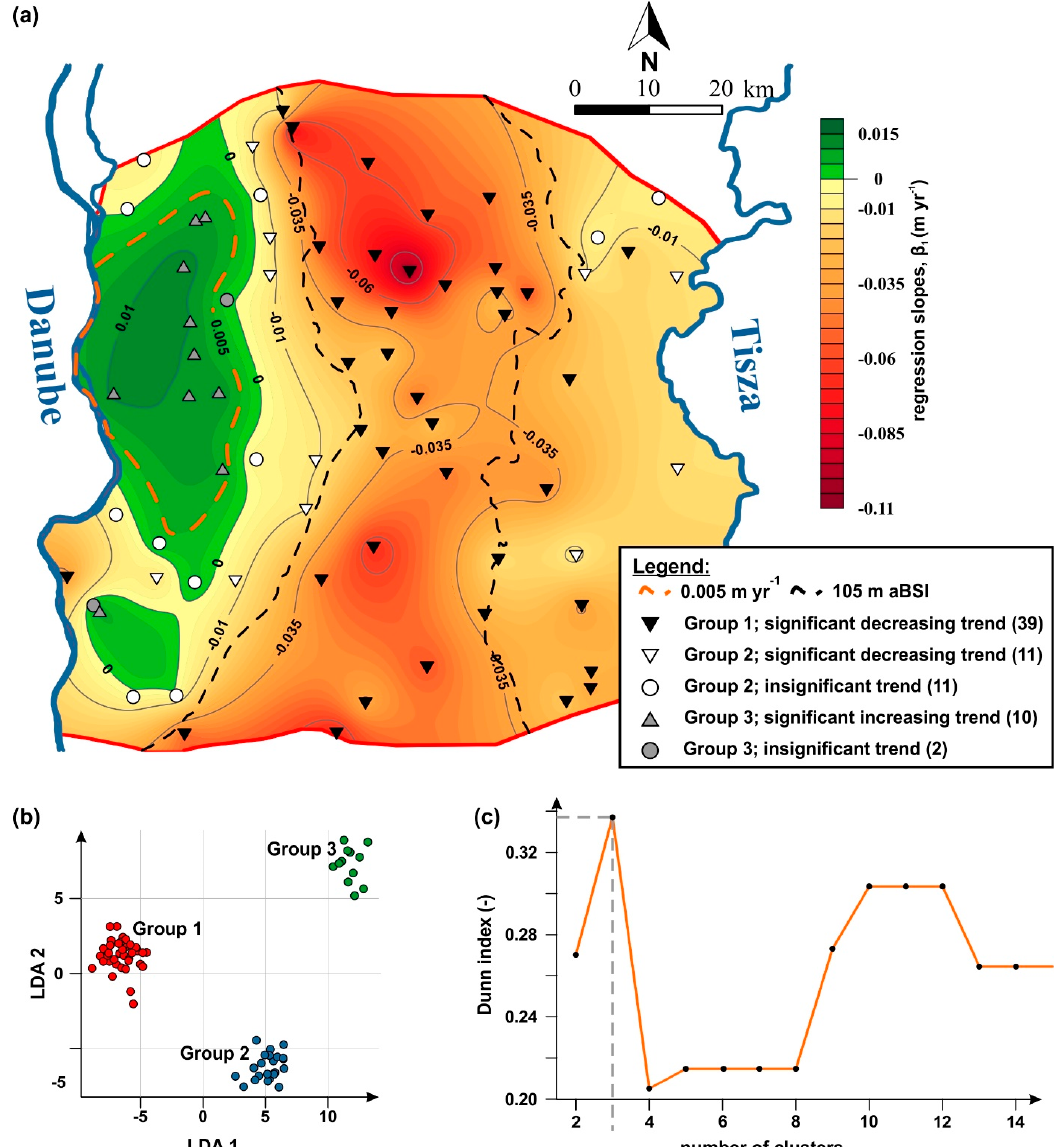
Figure 4. ( a ) Three cluster groups (indicated by different colors) of the SGW level time series and the average temporal trend of the groups (1961 to 2010), indicated by different symbols; ( b ) results of the linear discriminant analysis; and ( c ) Dunn index corresponding to the different possible groupings obtained by HCA. The highest index value in ( c ) indicates the optimal number of groups. The base map of ( a ) is the kriged map of the slopes ( β 1 ) of SGW table change The dashed black line in the map shows the topographic elevation of 105 m aBSl; the dashed orange line is the 0.005 m y − 1 contour line on the maps The properties of the semivariogram can be found in Figure S6c.